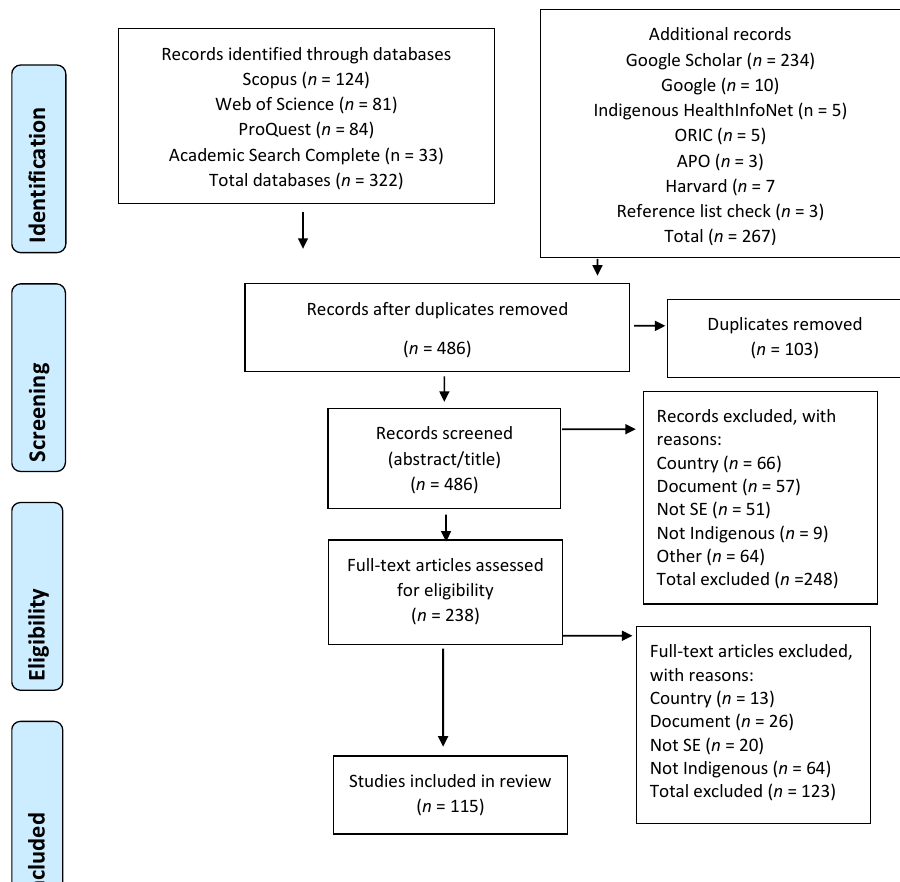
Figure 1. PRISMA Flowchart